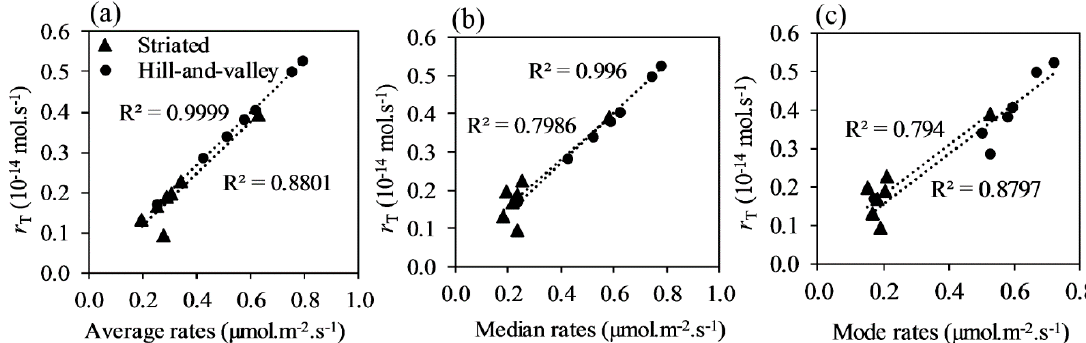
Figure 8. Correlation between the total material flux ( r T ) and the rate central statistical parameters in the striated surface and hill-and-valley surface morphologies in all seven reaction time intervals: ( a ) average rates plotted against the total material flux; ( b ) median rates plotted against the total material flux; ( c ) Most frequent rate (rate modes) plotted against the total material flux. All plots show triangles for the striated surface morphology and circles for hill-and-valley surface type.